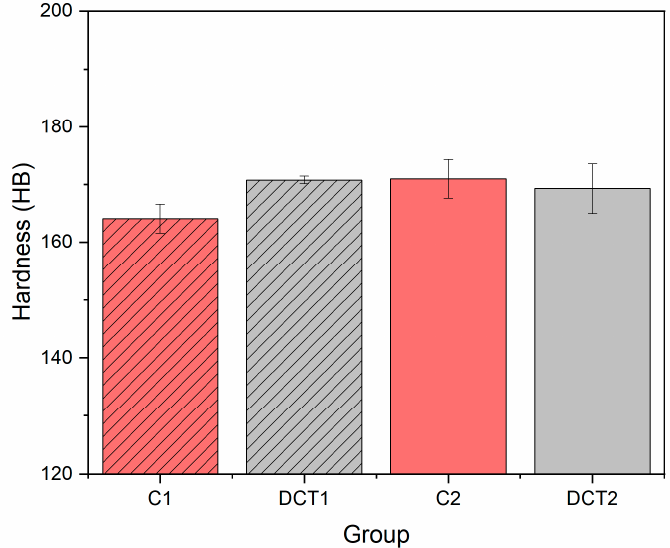
Figure 3. Measured hardness in HB for all four subgroups, C1 and C2 are conventional solution annealing groups, whereas DCT1 and DCT2 are deep cryogenically heat-treated with SD.